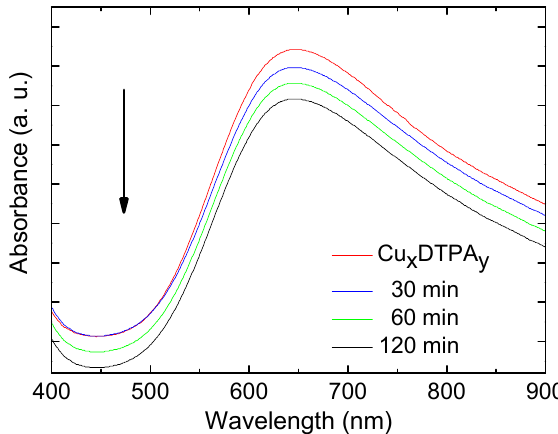
Figure 10. UV–Vis spectra of the copper complex in an aqueous solution with the absorbance decay curves of the supernatants.